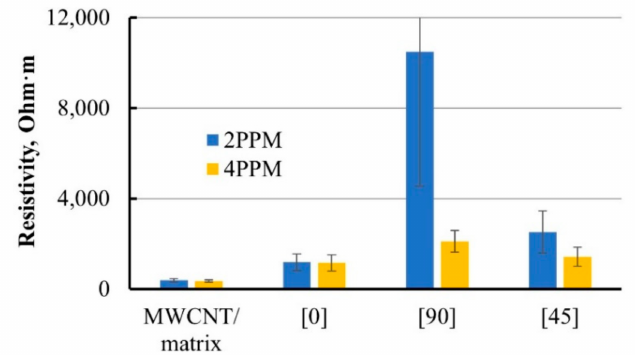
Figure 7. Comparison of 2- and 4-point probe methods (2 PPM and 4 PPM, respectively) for resistivity measurement of 0.3 wt.% MWCNT-modified matrix and its based composite bars with reinforcing angles 0 ◦ , 90 ◦ , and 45 ◦ .